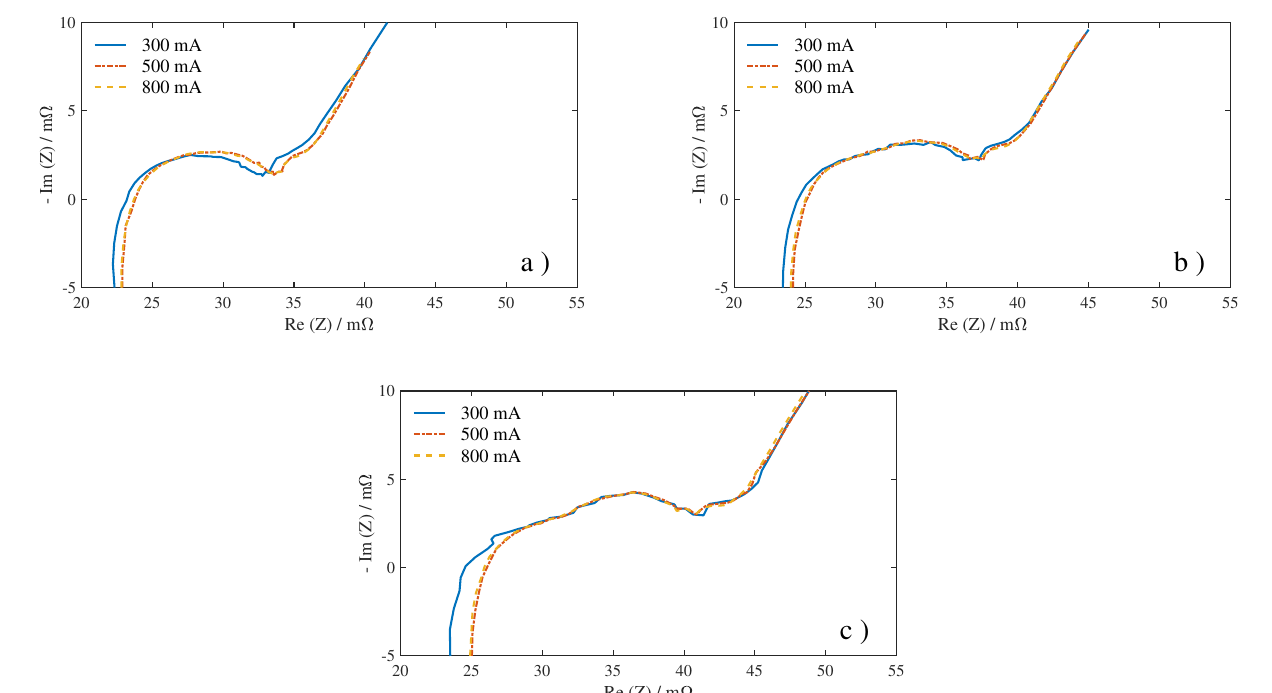
Figure 14. The impedance spectra at 80% SoC for the battery tested under 45 ◦ C@0.5–1 C condition after: ( a ) 50 cycles; ( b ) 150 cycles; and ( c ) 250